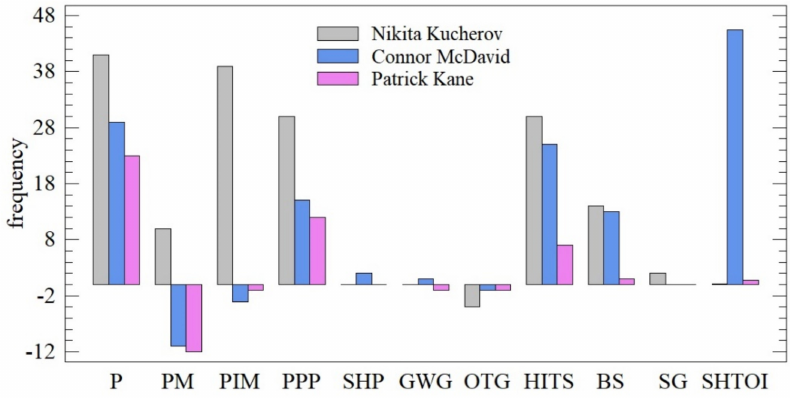
Figure 7. Comparison with the best player as evaluated by the CV–TOPSIS combination (Artemi Panarin).